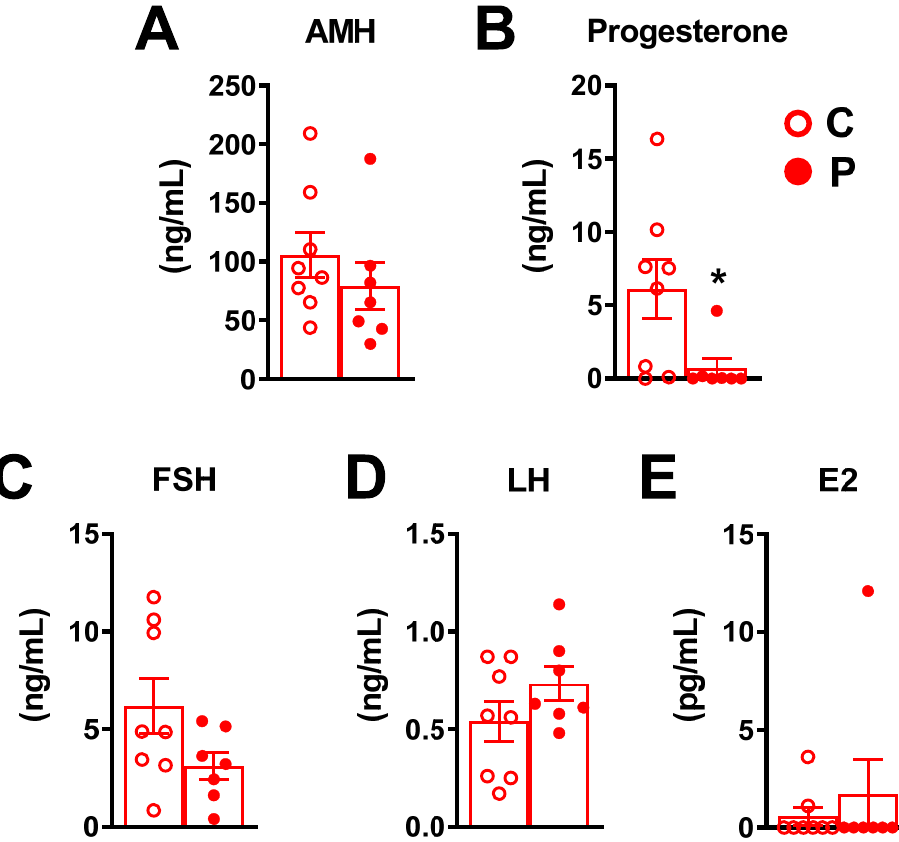
Figure 6. Hormonal serum levels in exposed and unexposed 8-week-old female offspring. Serum levels (ng/Lml) of ( A ) AMH, ( B ) progesterone, ( C ) FSH, ( D ), LH and ( E ) 17b oestradiol in exposed and unexposed female offspring at 8 weeks of age. Data are presented as mean ± SEM. * p < 0.05.